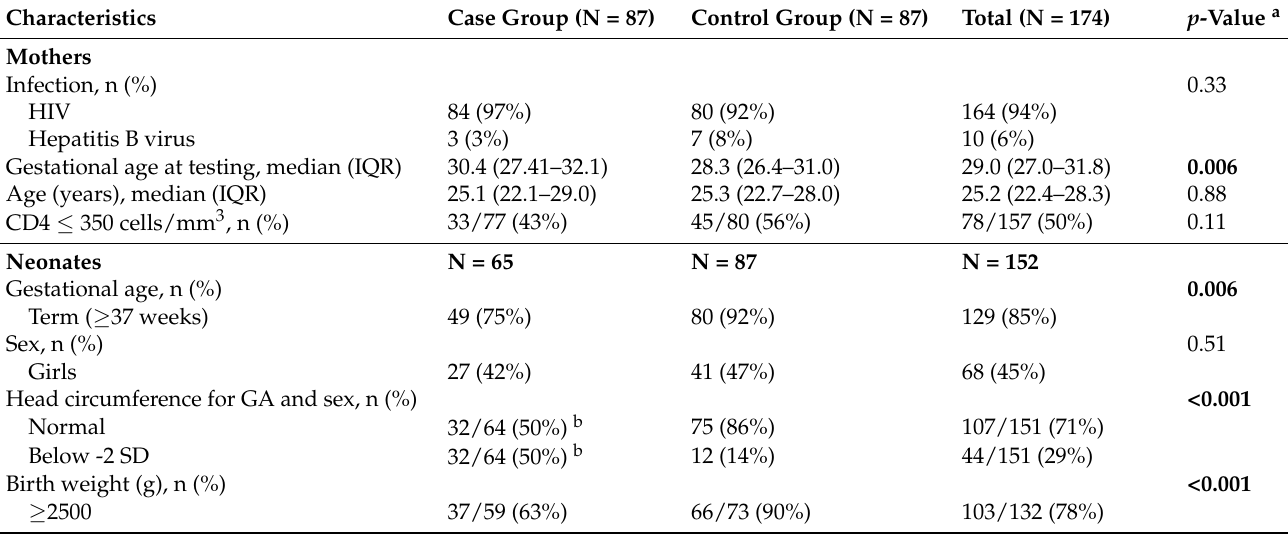
Table 1. Characteristics of mothers and neonates in Case and Control